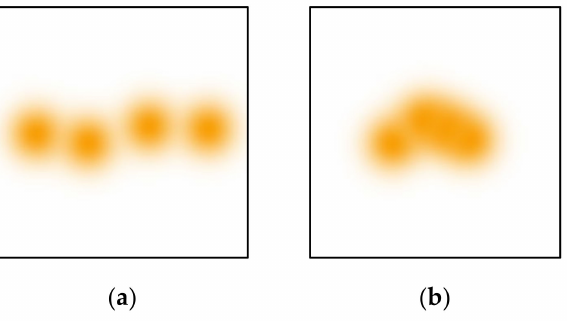
Figure 4. ( a ) Zone of Theoretical Visibility (ZTV) of dolphins in Figure 1a; ( b ) ZTV of dolphins in Figure 1b.